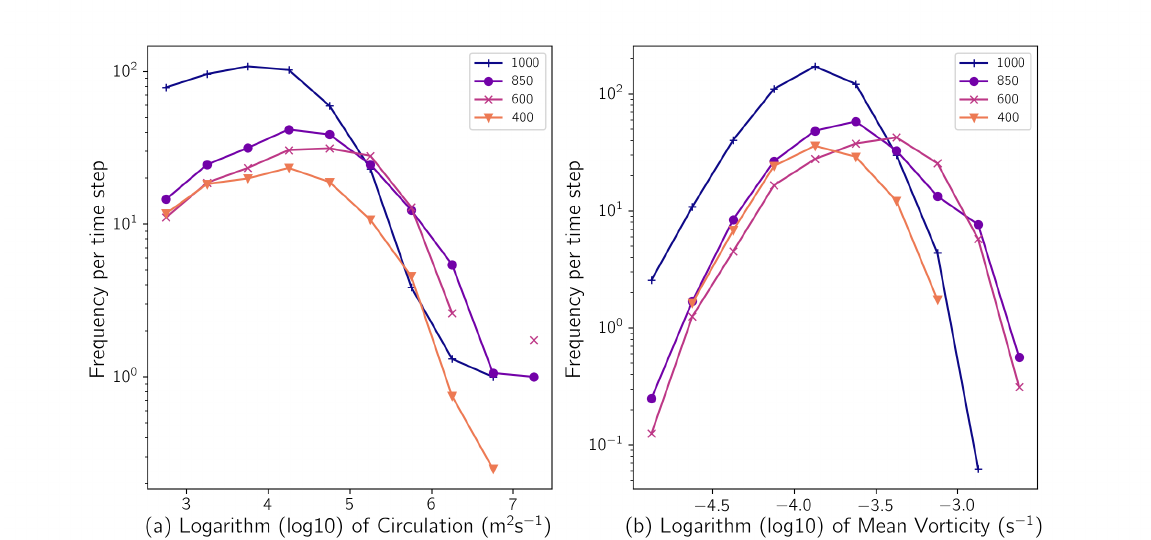
Figure 13. Frequency-intensity distributions per 15-min time steps of all vortex structures identified in the COSMO dataset that lie inside Kyrill’s NCEP radius for different height levels: ( a ) logarithm of circulation (m 2 s − 1 ) and ( b ) logarithm of the mean vorticity (s − 1 ).